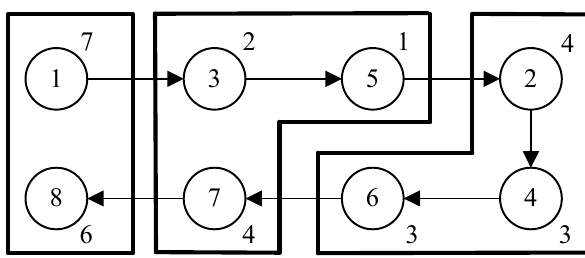
Figure 8. An example for set A w and B j calculation.